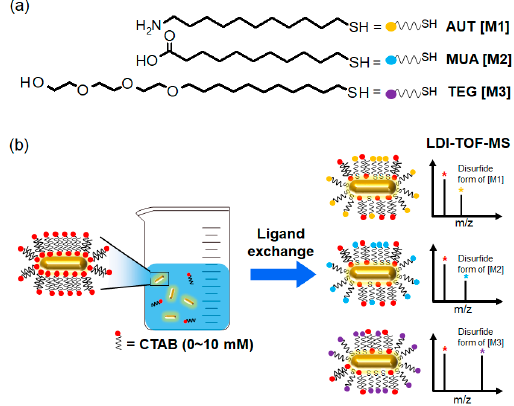
Figure 1. ( a ) Structures of the thiol derivatives AUT, MUA, and TEG. ( b ) Ligand exchange of Au NRs with the thiol derivatives AUT, MUA, and TEG in the presence of different concentrations of CTAB and subsequent surface characterization of the Au NRs by using LDI-TOF-MS. The red, yel- low, blue, and purple asterisks in LDI-TOF-MS spectra indicate CTAB and disulfide form adducts of M1, M2, and M3, respectively.